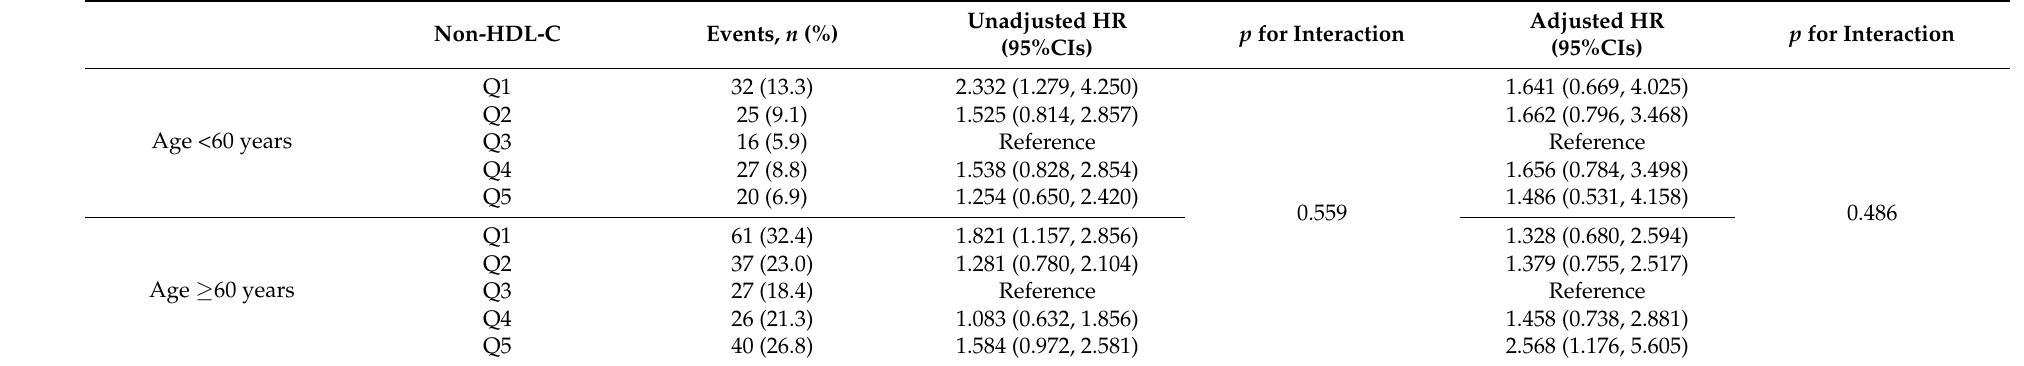
Table 5. HRs for the primary outcome by non-HDL-C level in various